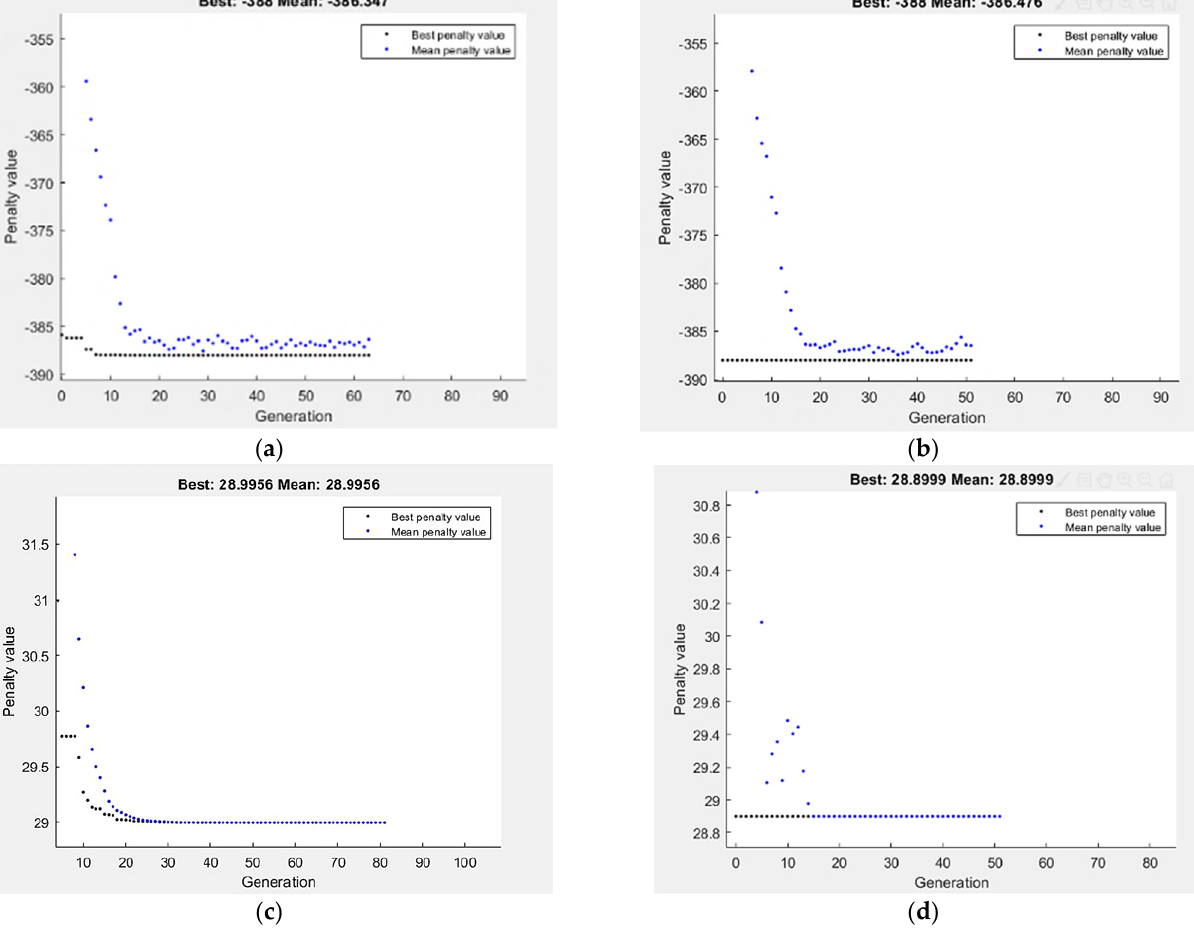
Figure 18. Optimum σ u ( a , b ), and D ( c , d ) by GA ( a , c ), and hybrid RSM-GA ( b , d ).